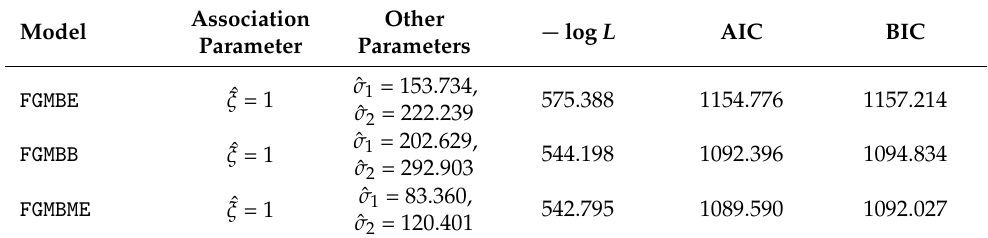
Table 2. ML estimates, log L , AIC, and BIC values of the considered −